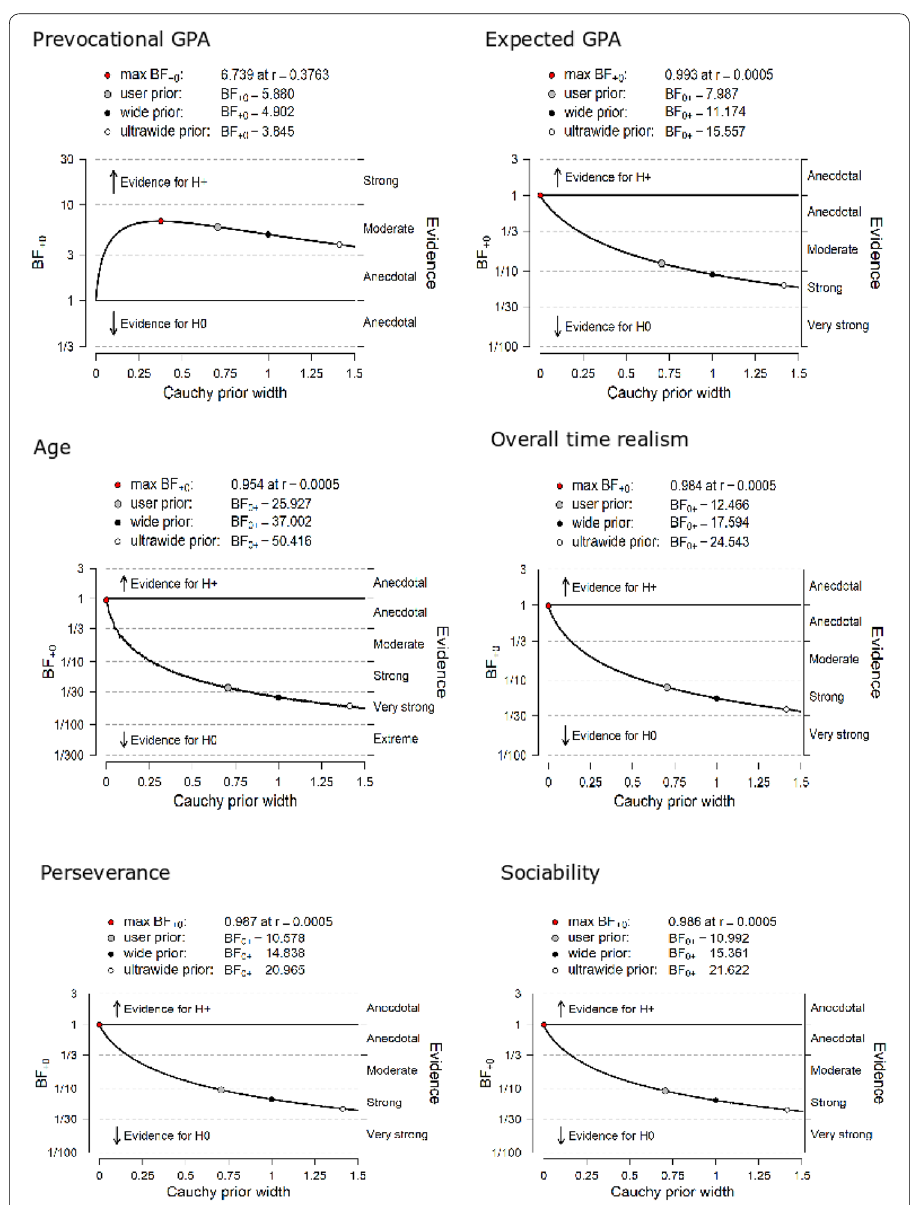
Fig. 3 Bayes factor robustness checks for strongest